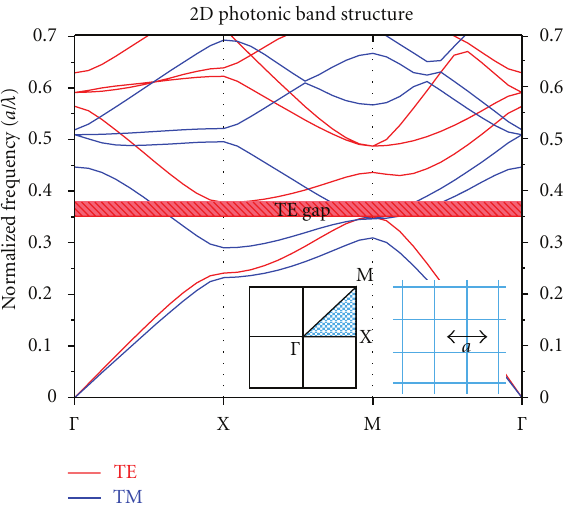
Figure 4: Complete TE gap map as a function of the PSi layer porosity. In the right y axis, equivalent wavelength is indicated for a lattice parameter of a = 7 μ m, the same as the experimental one (see Section 3). In the top x axis, e ff ective refractive index is shown following